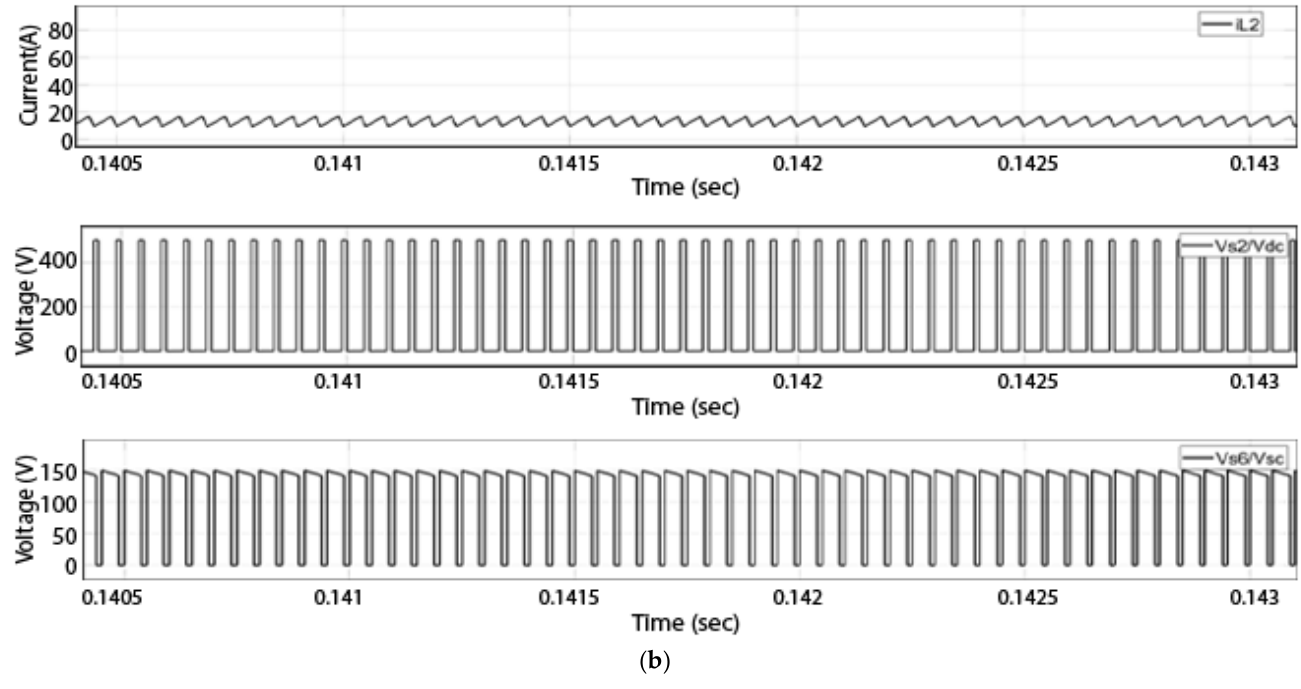
Figure 10. ( a ) Voltages of switches S 6 and S 2 and current of L 2 in mode 2(a). ( b ) Voltages of switches S 6 and S 2 and current of L 2 in mode 2(b).